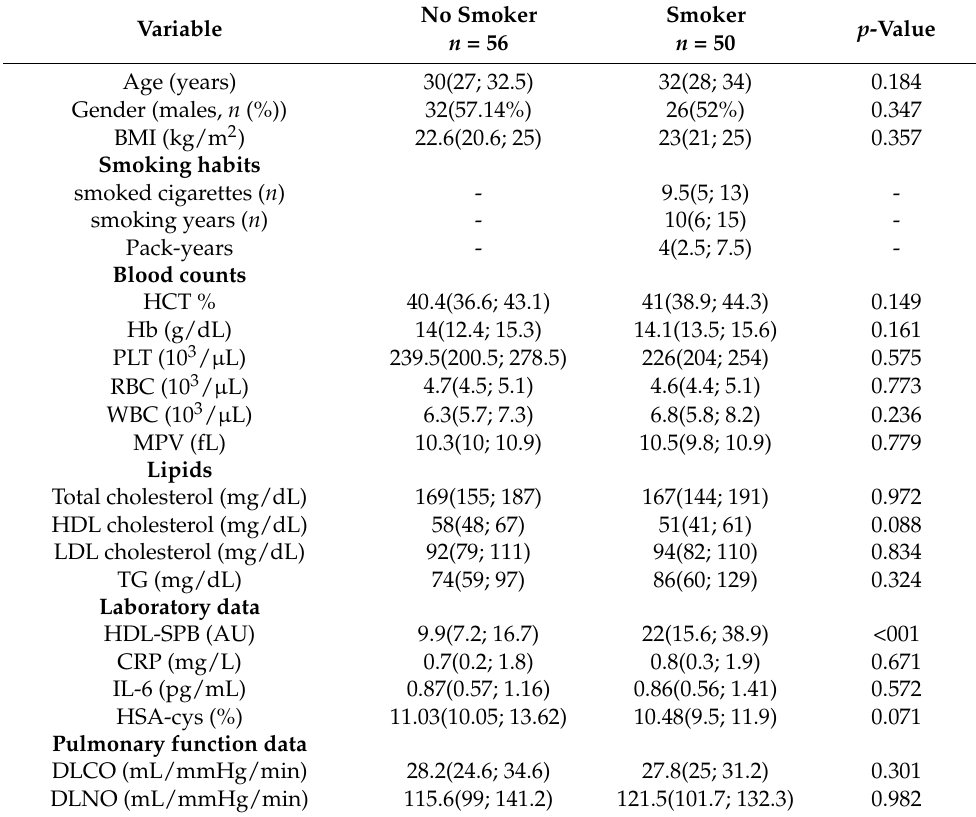
Table 1. Main clinical characteristics and laboratory data for the study